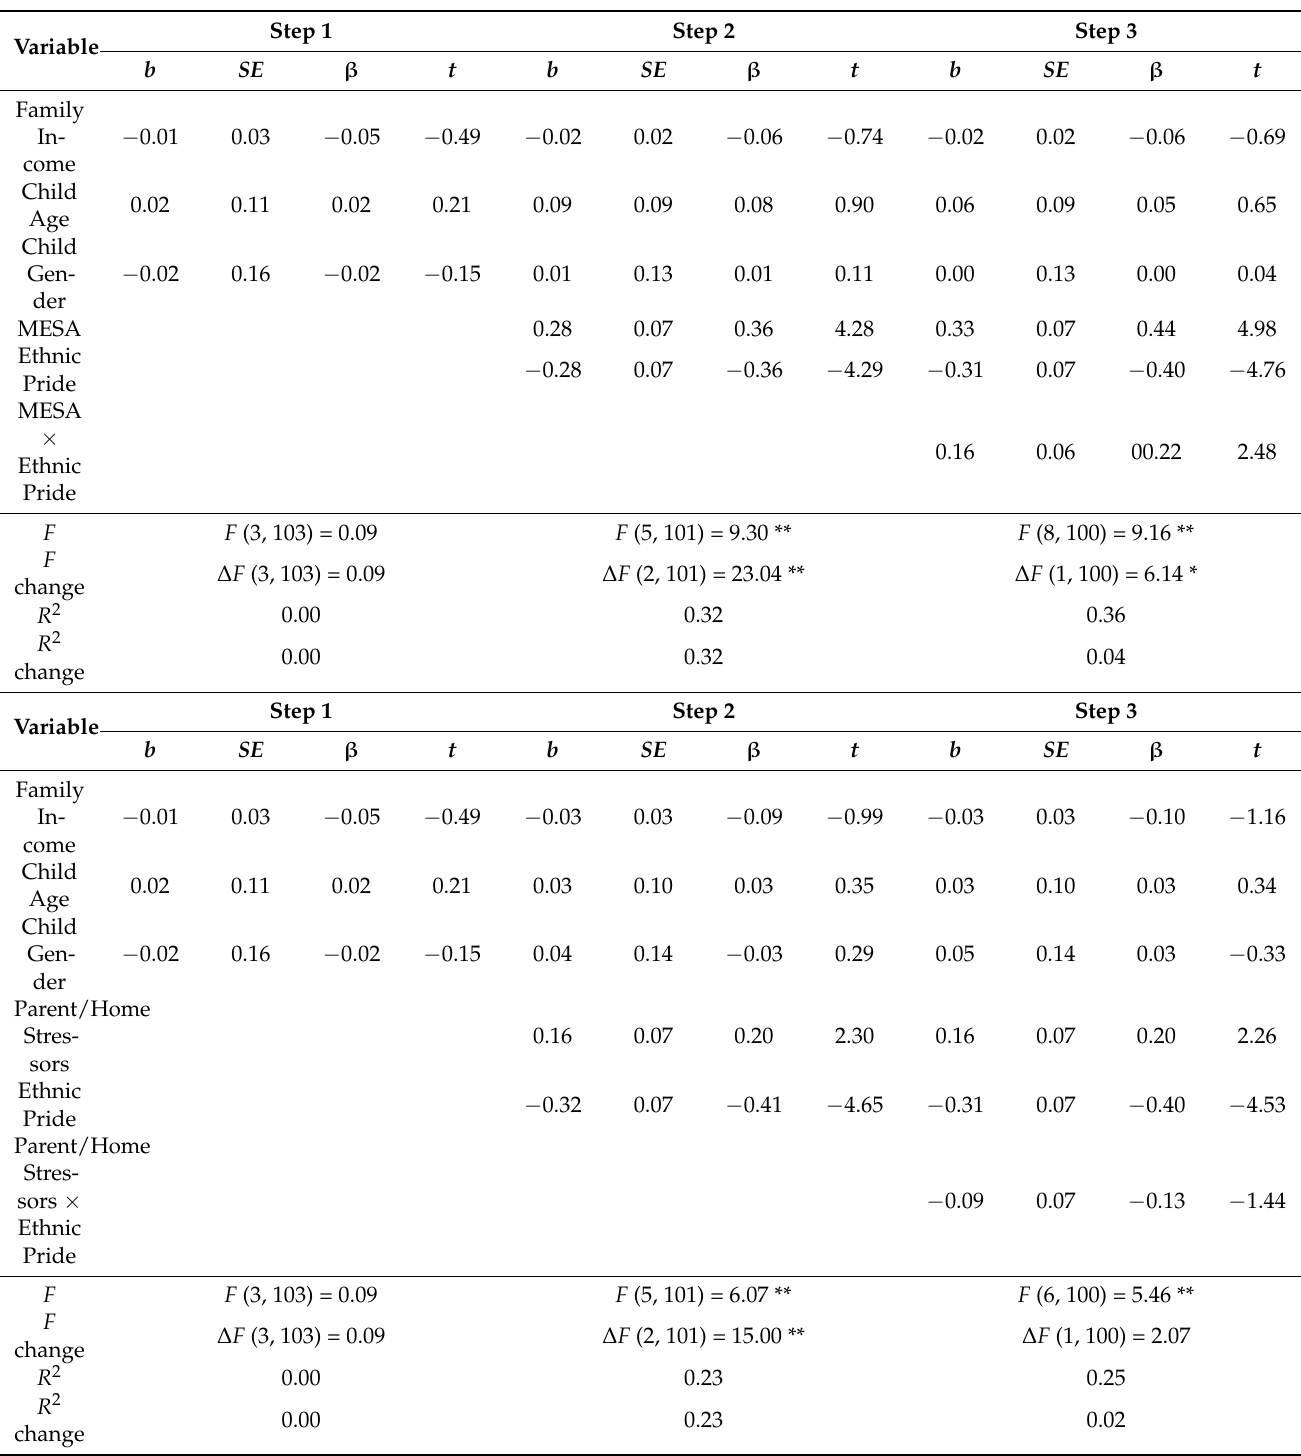
Table 4. Moderated regression analysis of the role of ethnic pride on child